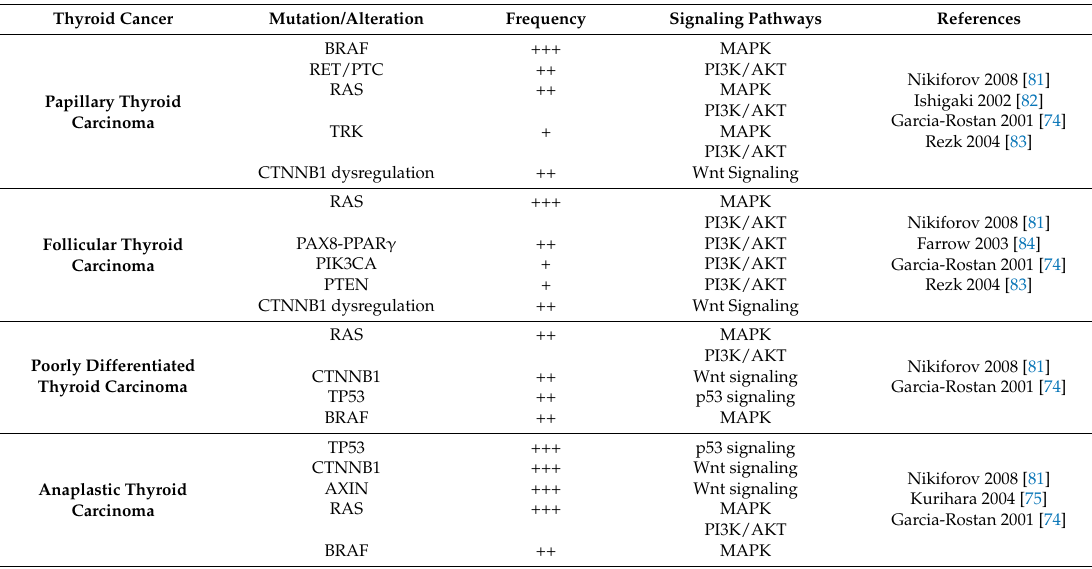
Table 2. Non-medullary thyroid cancer sub-types and their most common